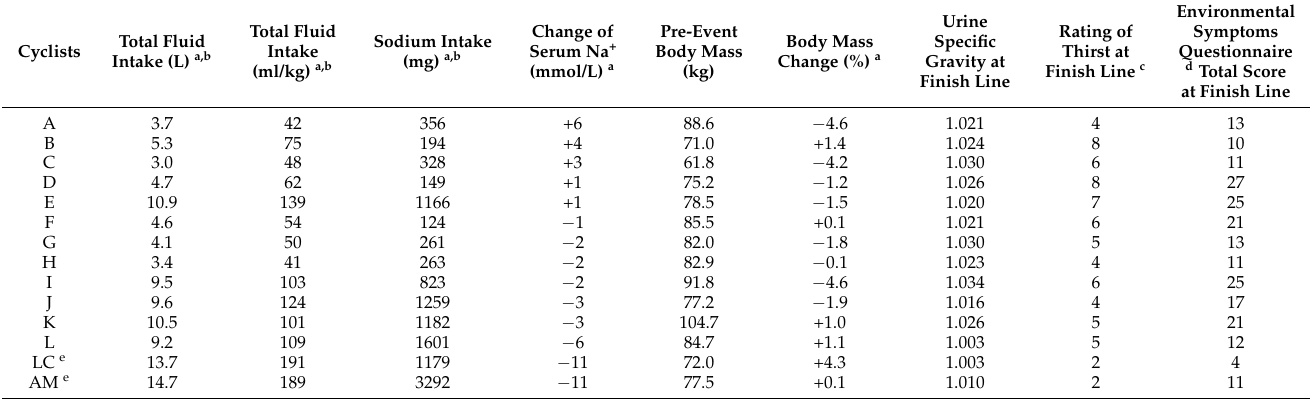
Table 3. Athlete physiological and perceptual responses during a summer road cycling event (7.1–10.9 h duration). Data are rank-ordered on the basis of serum Na + change (column 5). Modified from [66] with unpublished data added.